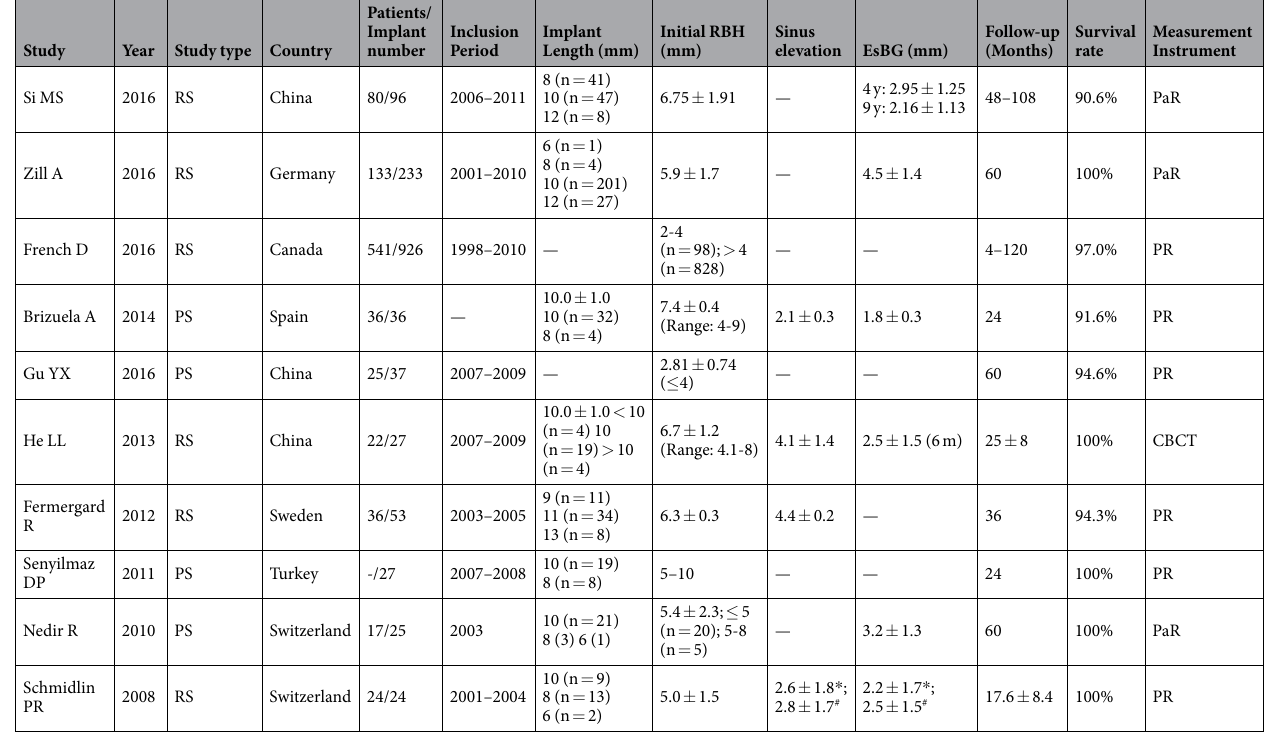
Table 1. Characteristics of non-controlled studies. PaR, periapical radiograph; PR, panoramic radiograph; CBCT, cone beam computed tomography; PS, prospective study; RS, retrospective study; * mesial aspect; #